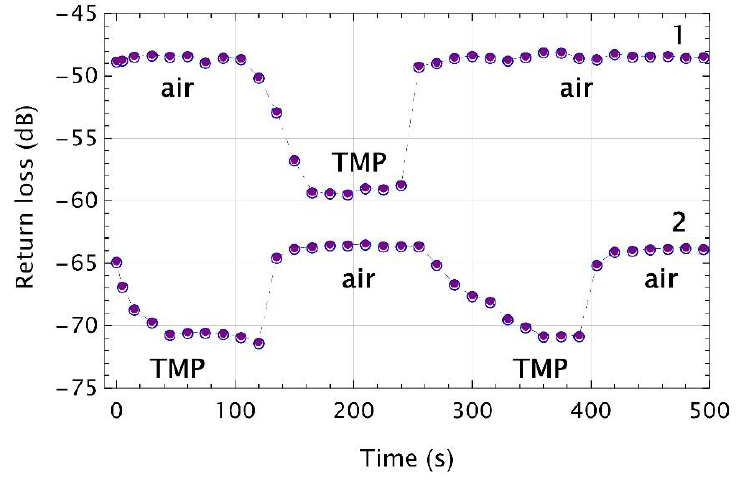
Figure 8. Time responses of the MMF 105 with a VIS microtip when the microtip was sequentially inserted into and removed from the glass vial filled with a 50 µL TMP. Empty circles with dots are experimental points, while the dashed lines are data interpolation.